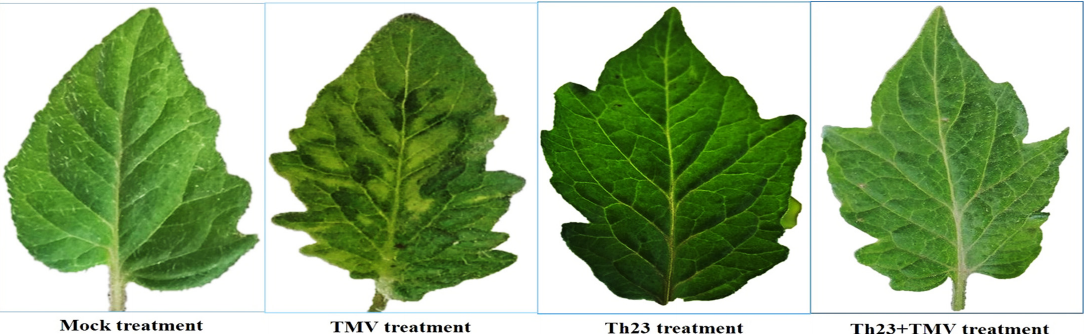
Figure 2. The protective activity of Trichoderma hamatum isolate Th23 against TMV on tomato leaves at 15 dpi (Th23 + TMV treatment). TMV treatment showed mild mosaic symptoms compared to Th23 and the mock treatments showed no developed symptoms.